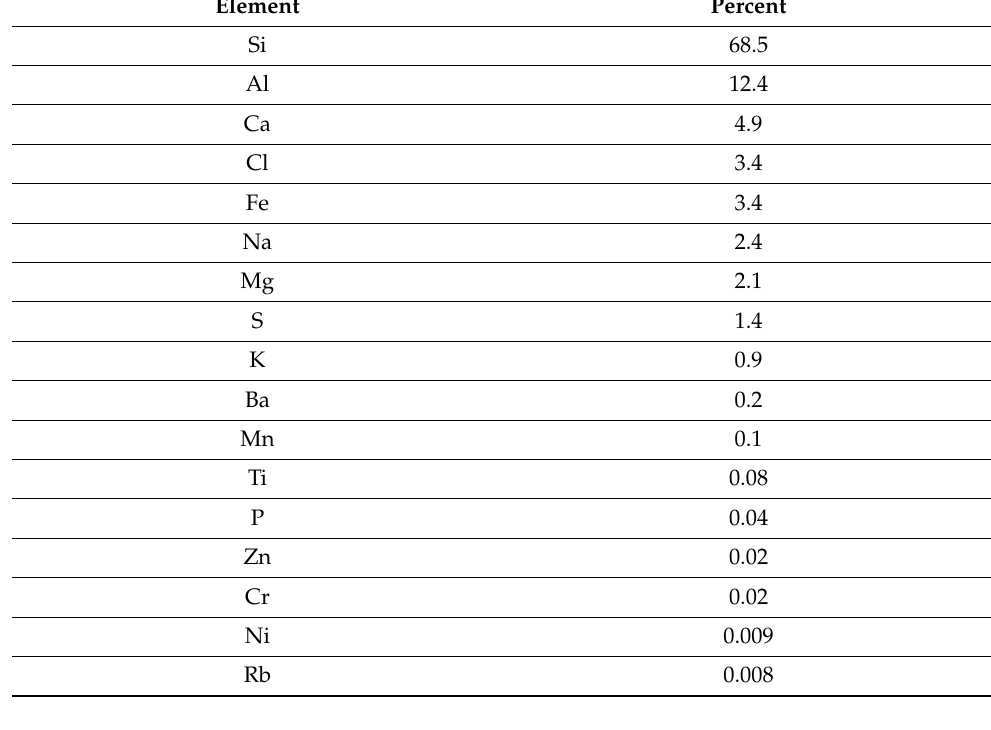
Table 2. XRF elemental analysis of used bentonite.